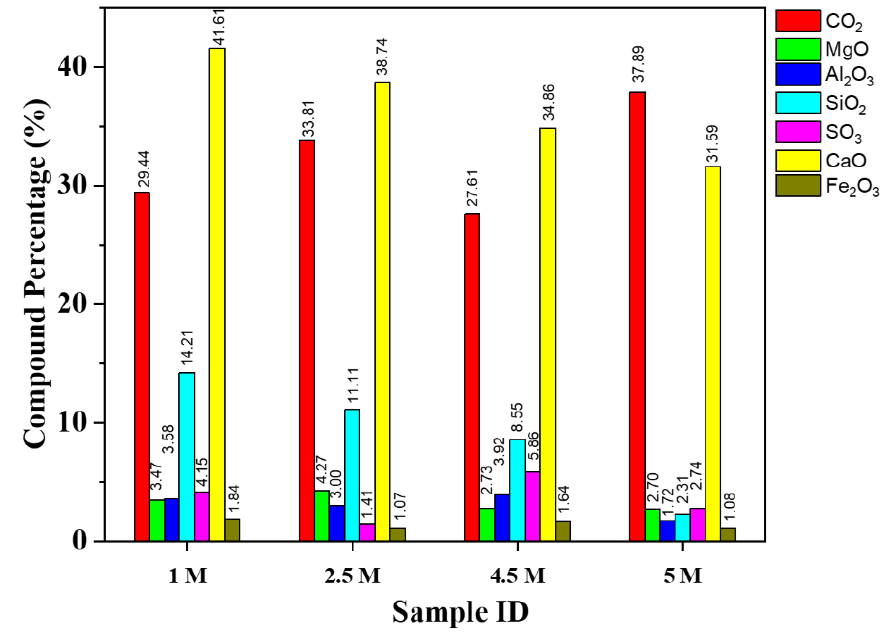
2 SO 4 /untreated. Figure 5. Compound composition of samples treated with H